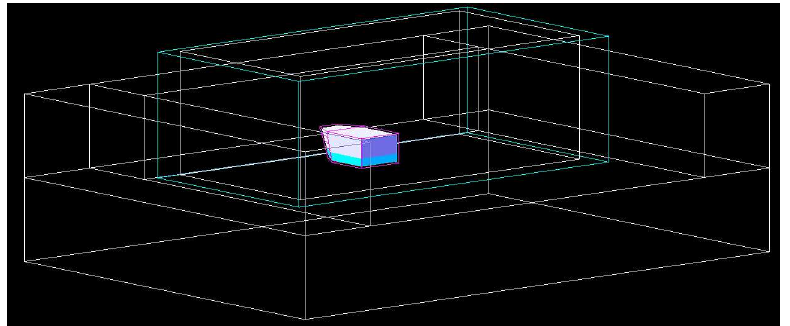
Figure 11. Geometry of the GEANT4 global geometry model for dose repartition.